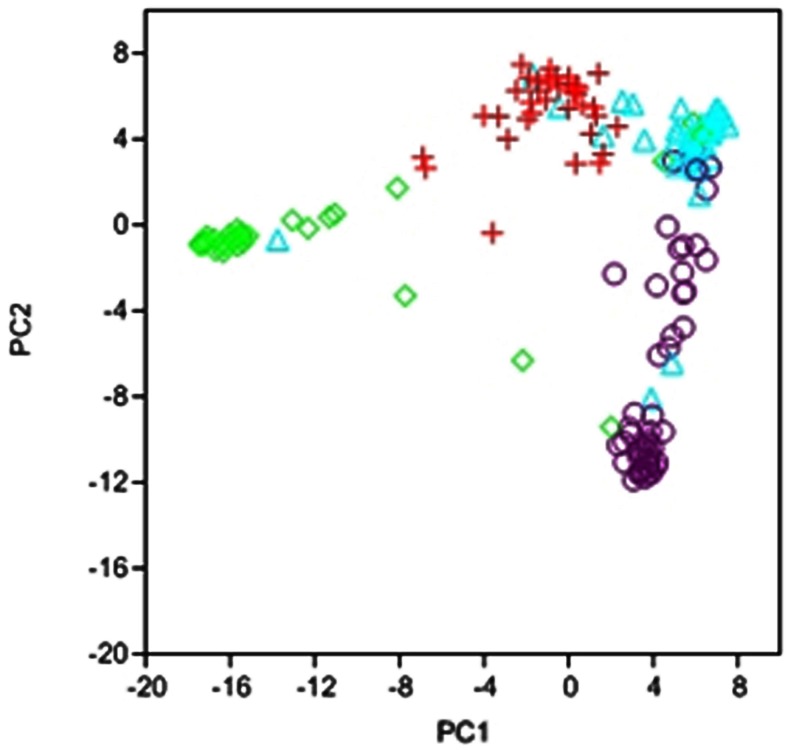
Scatterplot of Principal Component Analysis scores of components 1 and 2 based on 1712 DArT and SSR markers used in this study. Represented are the genotypes belonging to cluster 1 (red), cluster 2 (green), cluster 3 (violet), and cluster 4 (blue).